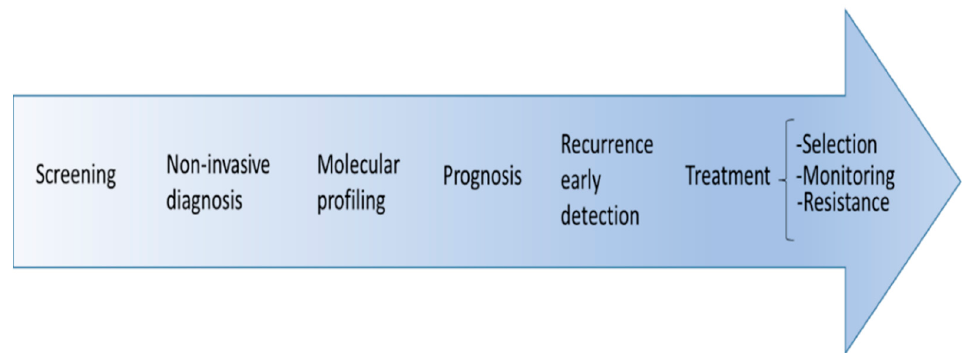
Figure 1. Potential application of liquid biopsy in pancreatic cancer.